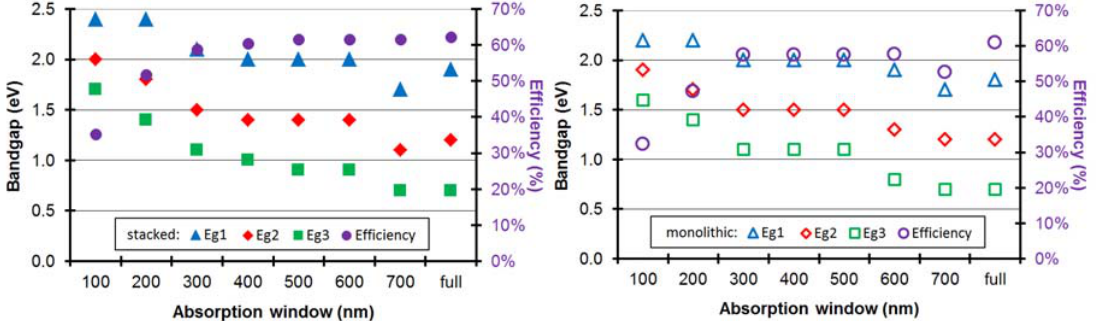
Figure 8. The maximum efficiency and the optimum bandgaps are plotted in the ideal scenario (with  LUMO = 0.2 eV) for an organic stacked and monolithic triple-junction cell as a function of the absorption window.